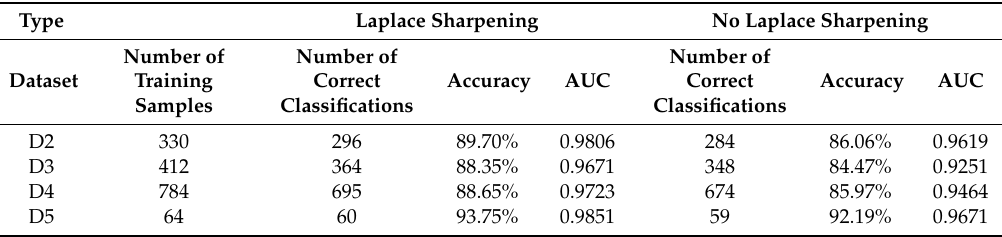
Table 11. The results of the surface crack classification in UAV images using Laplace sharpening and no Laplace sharpening.